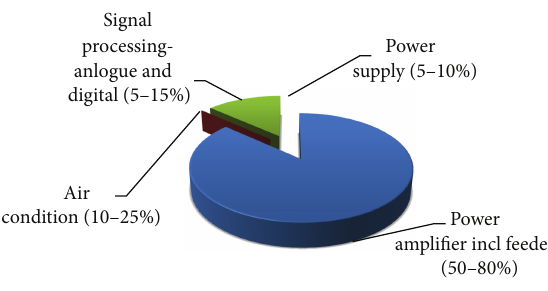
Figure 1: Energy consumption of the various components of the base stations